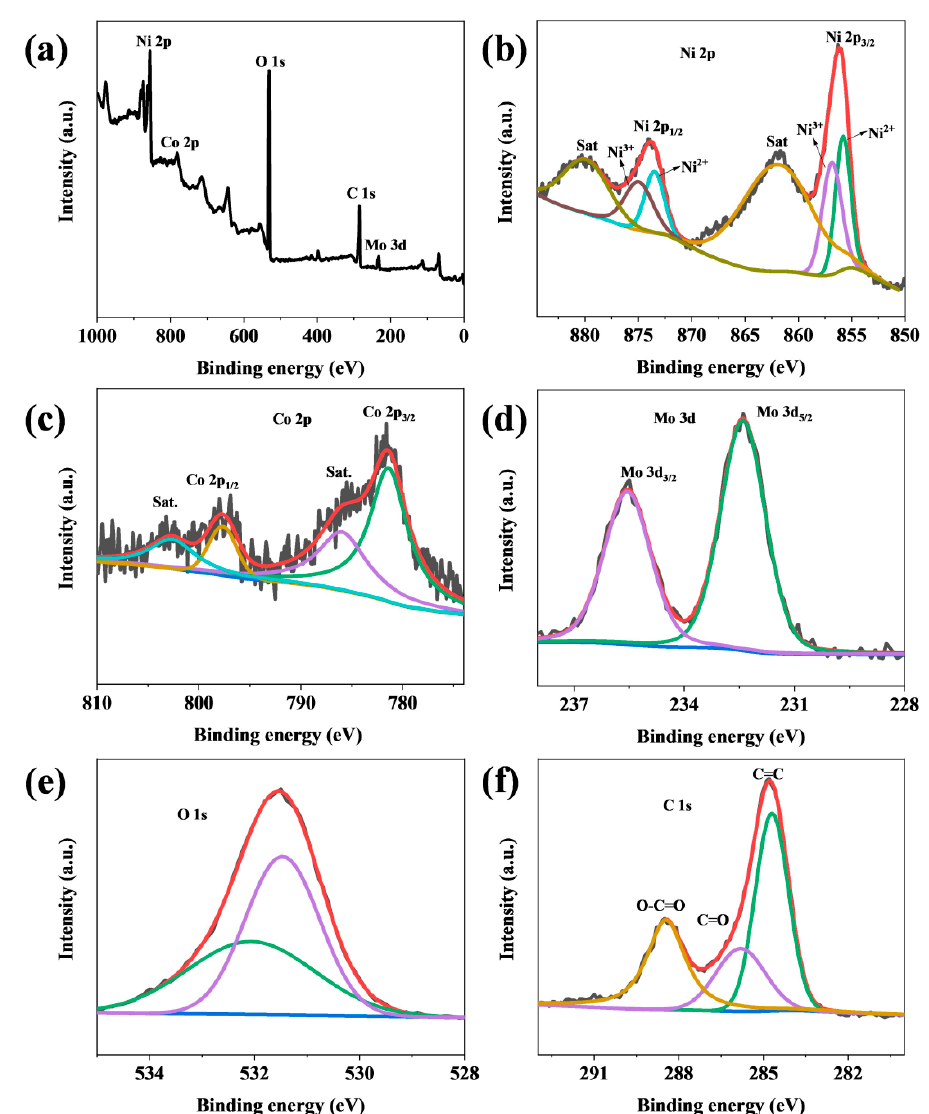
Figure 4. ( a ) XPS survey of the NiMo-LDH@NiCo-MOF, ( b ) Ni 2p, ( c ) Co 2p, ( d ) Mo 3d, ( e ) O 1s, and ( f ) C 1s. In the Ni 2p spectrum, Ni 2+ corresponds to green and blue, and Ni 3+ corresponds to purple and dark brown. Satellite peaks correspond to light brown, and red corresponds to fitted peaks. In the Co 2p spectrum, green corresponds to Co 2p3/2, brown to Co 2p1/2, purple and blue to the satellite peaks of Co 2p, and red to the fitted peaks. In the spectrum of Mo 3d, green corresponds to Mo 3d5/2, purple corresponds to Mo 3d3/2, and red corresponds to the fitted peak. In the spectrum of O 1s, purple corresponds to metal-oxygen bonds in metal oxides, and green corresponds to oxygen in hydroxyl ions. The red corresponds to the peaks of the fit. In the spectrum of C 1s, green corresponds to the C=C bond, purple corresponds to C=O, brown corresponds to the O-C=O bond, and red corresponds to the fitted peak.